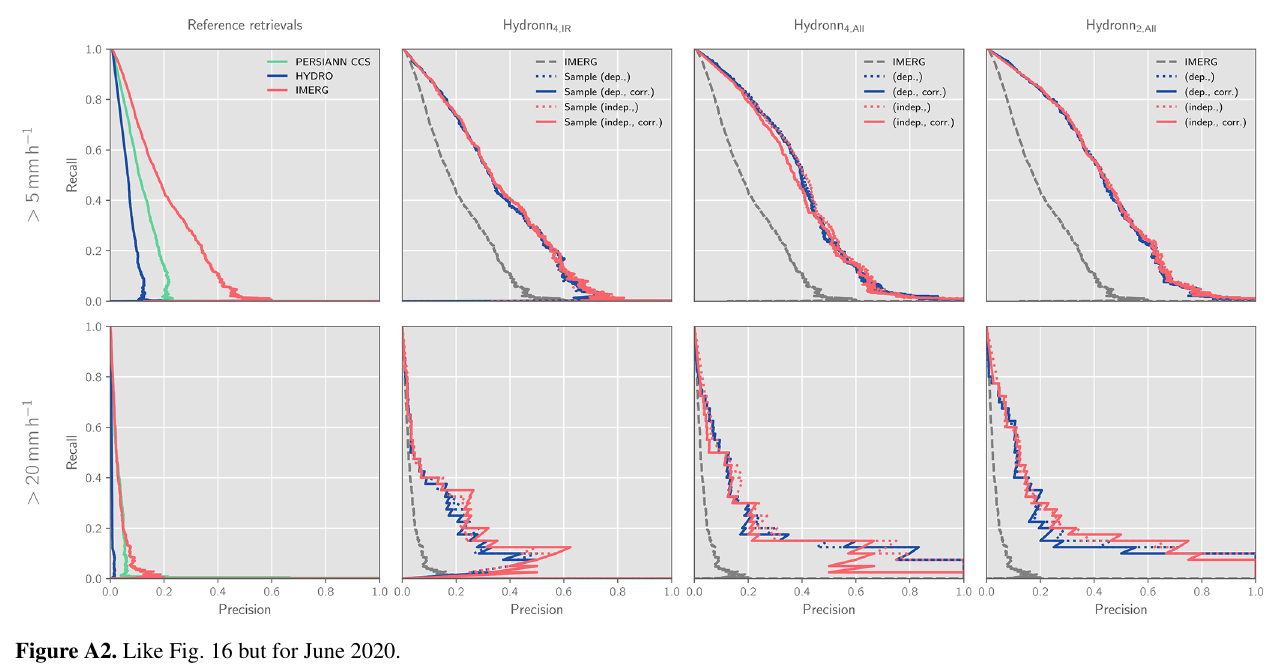
Figure A2. Like Fig. 16 but for June 2020.